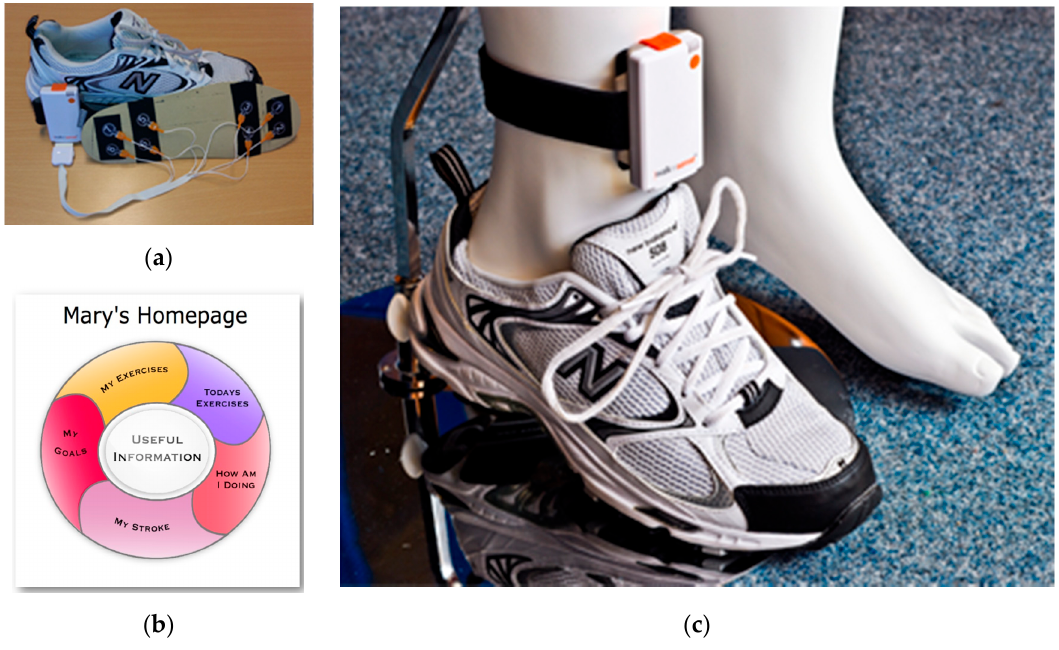
Figure 1. The prototype PSMrS for stroke survivors. The Walk-in-sense device (Kinematix, Porto, Portugal) ( a ); the user interface ( b ) and attachment of devices to lower limb on a manikin ( c ).